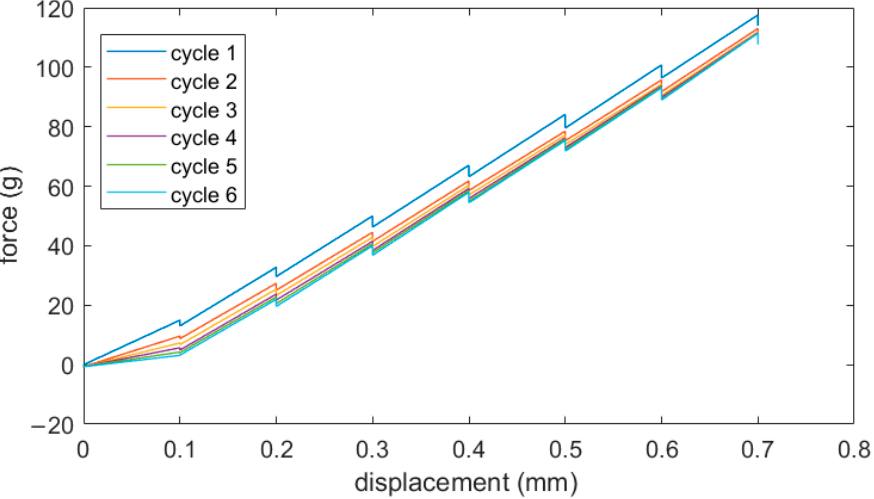
Figure 6. Applied force vs. displacement, considering the increasing traits of the 1st series of cycles of test D2. For increasing cycle index, the force reduces for a given strain, and this gap is higher than the 1st cycle, which is excluded from the analysis. Moreover, within each cycle, multiple force values are measured at the same displacement step due to the force settling time caused by the viscoelasticity of the TPU structure. Since strain changes in steps of 0.1 mm, the force between steps is linearly interpolated in the plot.